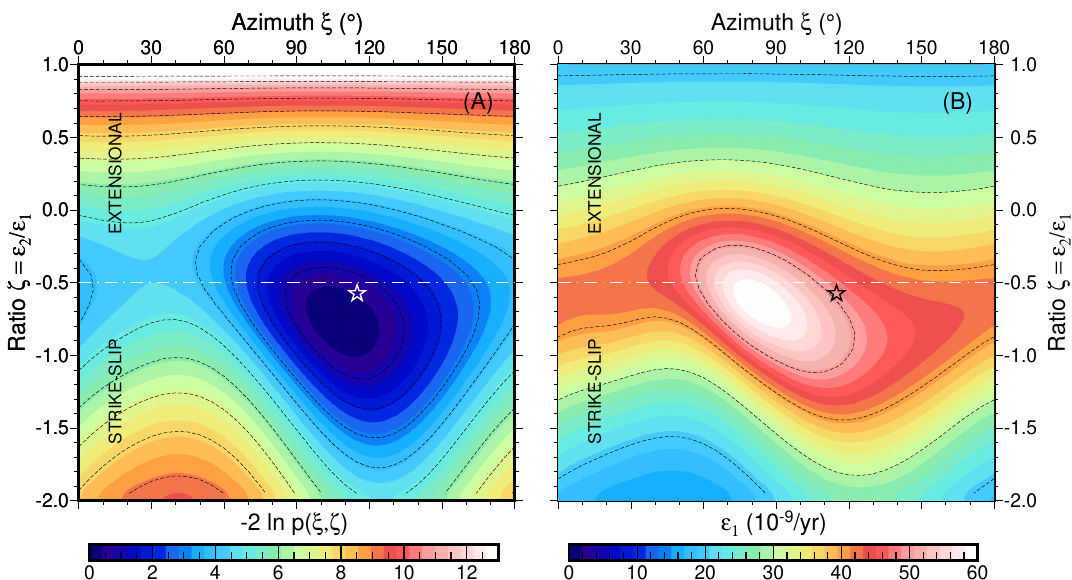
Figure 6. ( A ) Marginal PDF p (cid:48) ( ξ , ζ ) for the azimuth of maximum horizontal extension, ξ , and the ratio between horizontal principal strain rates, ζ = (cid:101) 2 / (cid:101) 1 , of extensional and strike-slip tectonic regimes for the inversion scheme FR (see Table 3). ( B ) Mean of the maximum horizontal strain rates E ( (cid:101) 1 | ξ , ζ ) at fixed tectonic regimes as function of the azimuth ξ and the ratio ζ . The (white and black) stars indicate the estimated tectonic regime for the inversion scheme FR and the contour lines are given every 1 unit in panel A and 10 − 8 /yr in panel B.